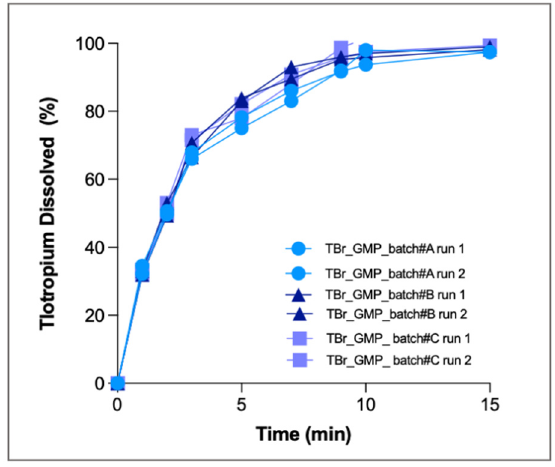
Figure 9. Cumulative mass (%) dissolution profiles of tiotropium bromide released by three small- scale GMP batches after aerosolisation.